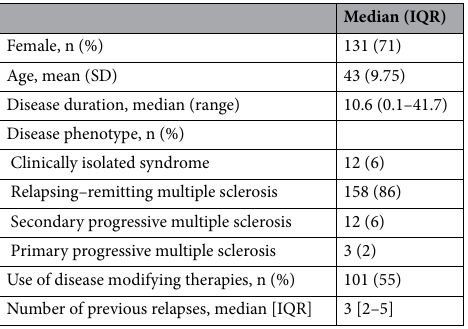
Table 1. Demographic and clinical characteristics of MS patients at baseline. The data represent the absolute numbers and proportions of qualitative data, or the median and interquartile range (IQR) for the quantitative data, unless otherwise specified. SD standard deviation.